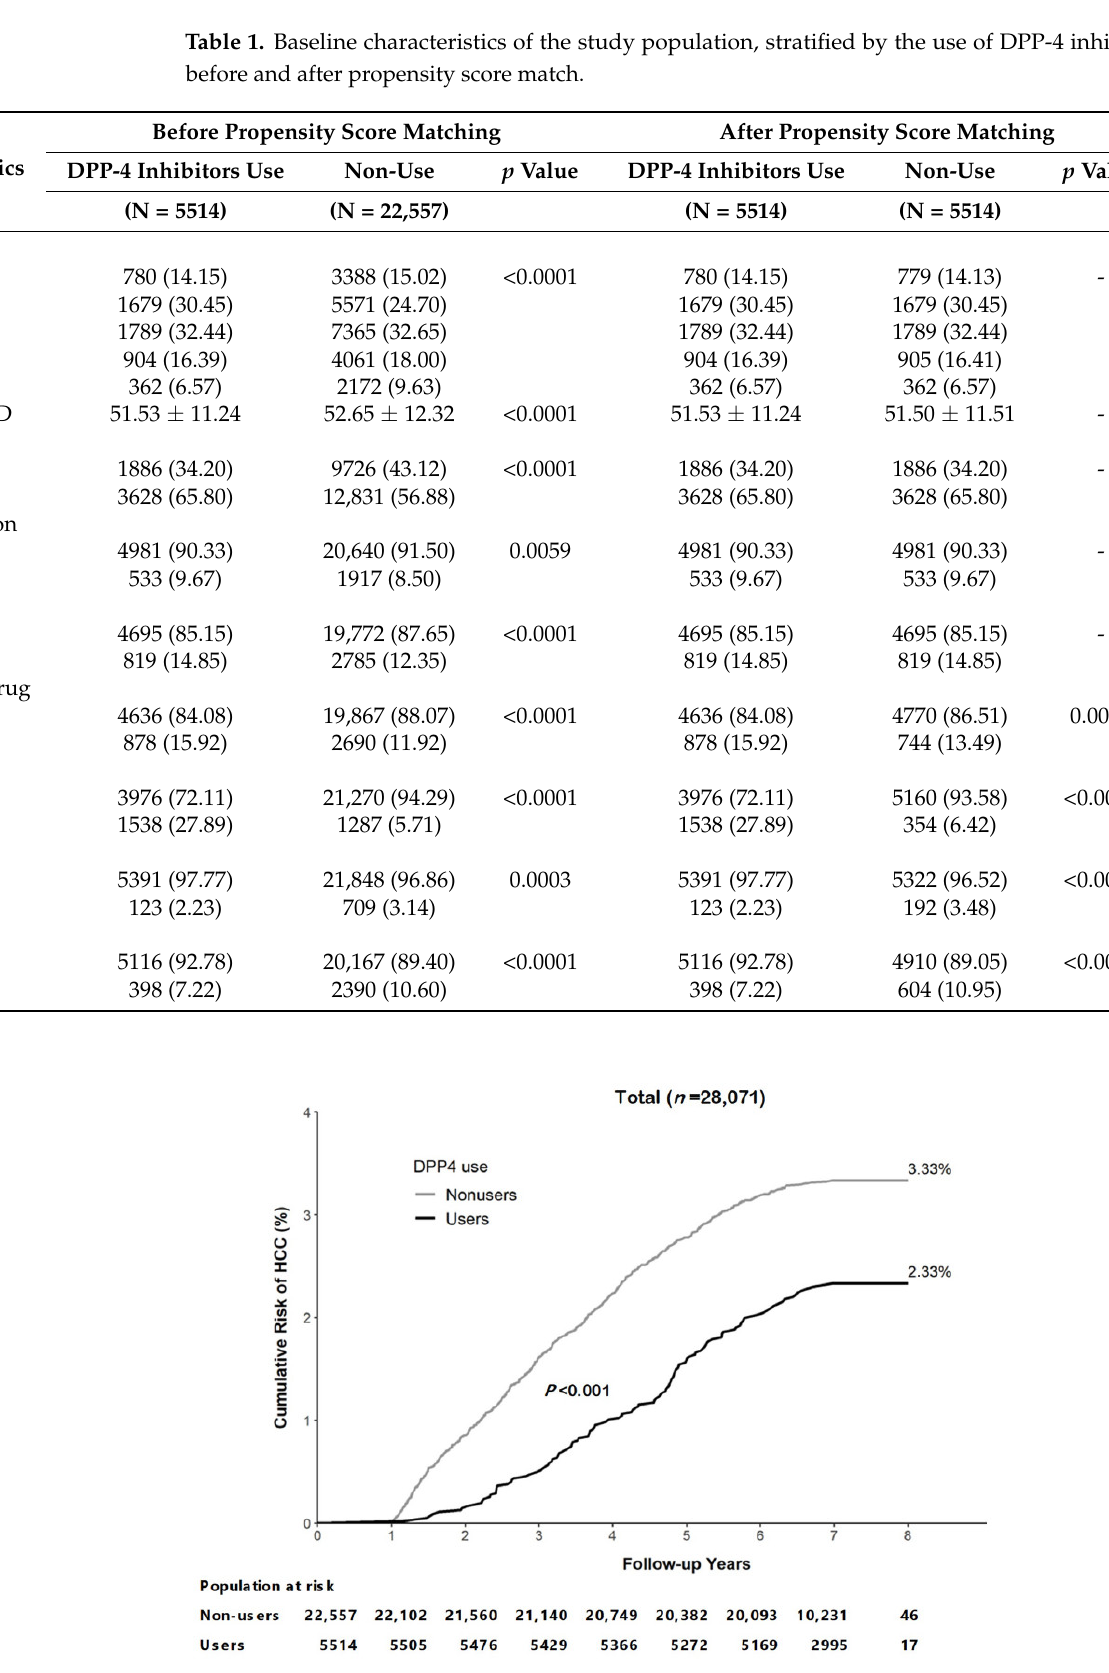
Figure 2. Cumulative risk of hepatocellular carcinoma (HCC) in T2DM patients with chronic HBV infection with and without DPP-4 inhibitors use.